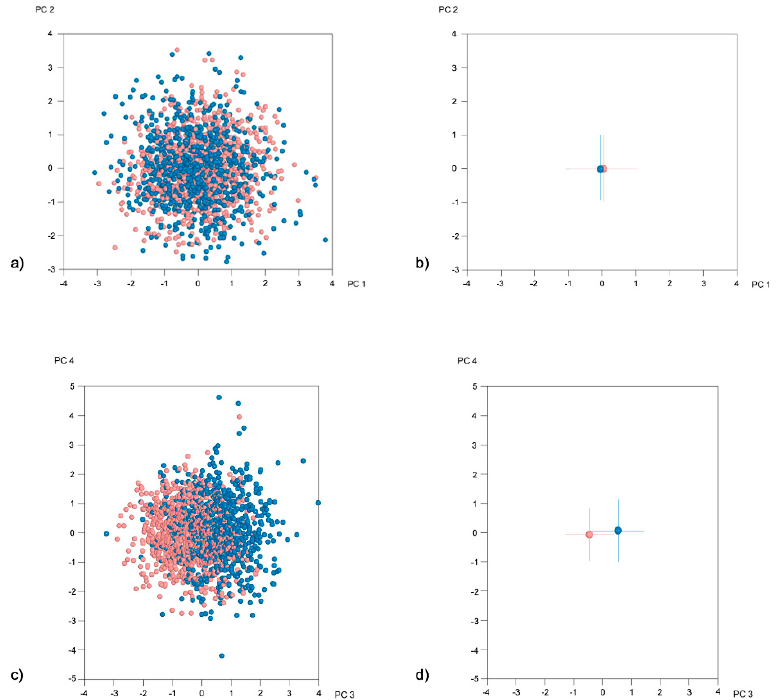
Figure 1. ( a ) Principal Component Analysis (PCA) graph displaying facial variation according to sex (in SD units), in the entire sample, as explained by PC1 (33.1%) and PC2 (23.1%) (Females: light red, Males: blue). ( b ) Average male (blue) and average female (light red) shape with respective SDs, as described by PC1 and PC2. ( c ) PCA graph displaying facial variation according to sex (in SD units), in the entire sample, as explained by PC3 (11%) and PC2 (6.7%) (Females: light red, Males: blue). ( d ) Average male (blue) and average female (light red) shape with respective SDs, as described by PC3 and PC4.